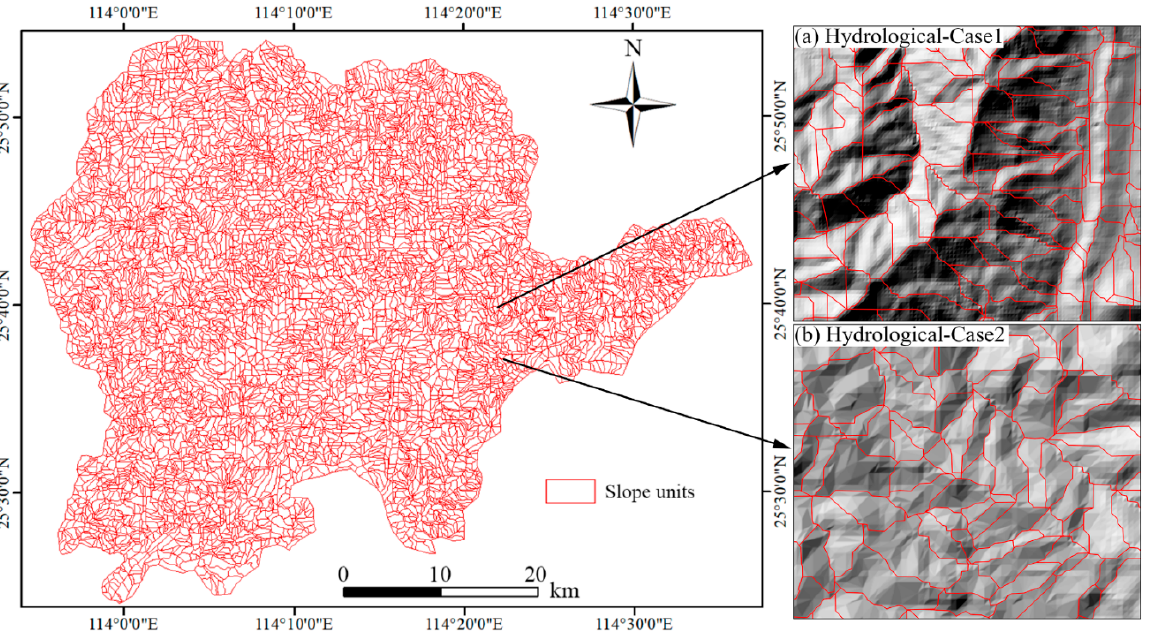
Figure 6. Slope units extracted by the hydrological method. ( a ) Hydrological-Case1; ( b ) Hydrological-Case2